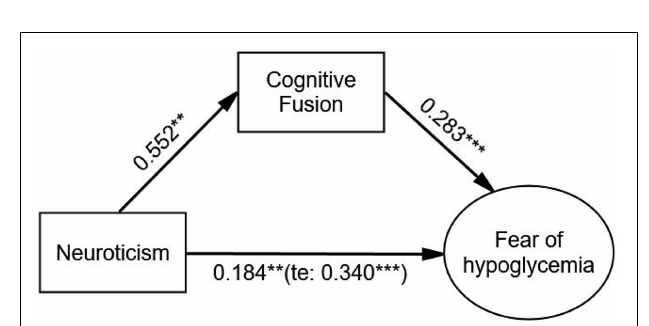
FIGURE 3 | The mediating effect of cognitive fusion on the relationship between neuroticism and FoH. Standardized estimating of 5,000 bootstrap sample. Age, sex, duration of diabetes, duration of insulin use, hypoglycemic episodes in the past year, and living alone were controlled. te, total effect. Significant codes: *** p < 0.001, ** p < 0.01.